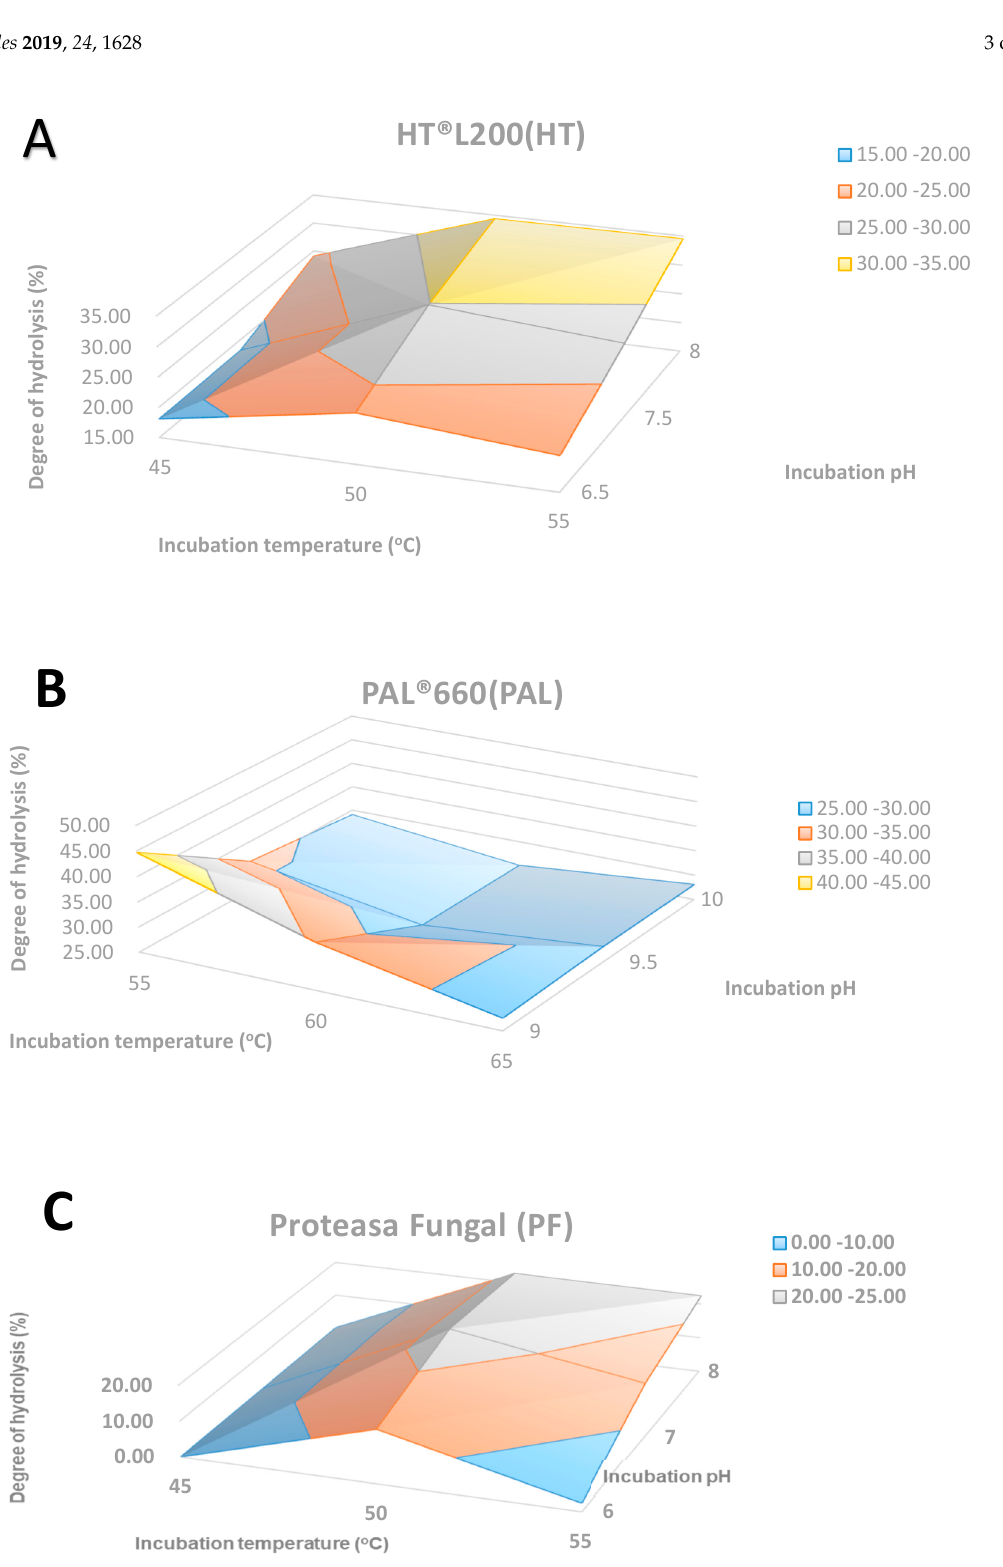
Figure 1. The degree of hydrolysis for each of the enzymes at various pH values and temperatures of hydrolysis: ( A ) HT hydrolysate; ( B ) PAL hydrolysate; ( C ) PF hydrolysate.